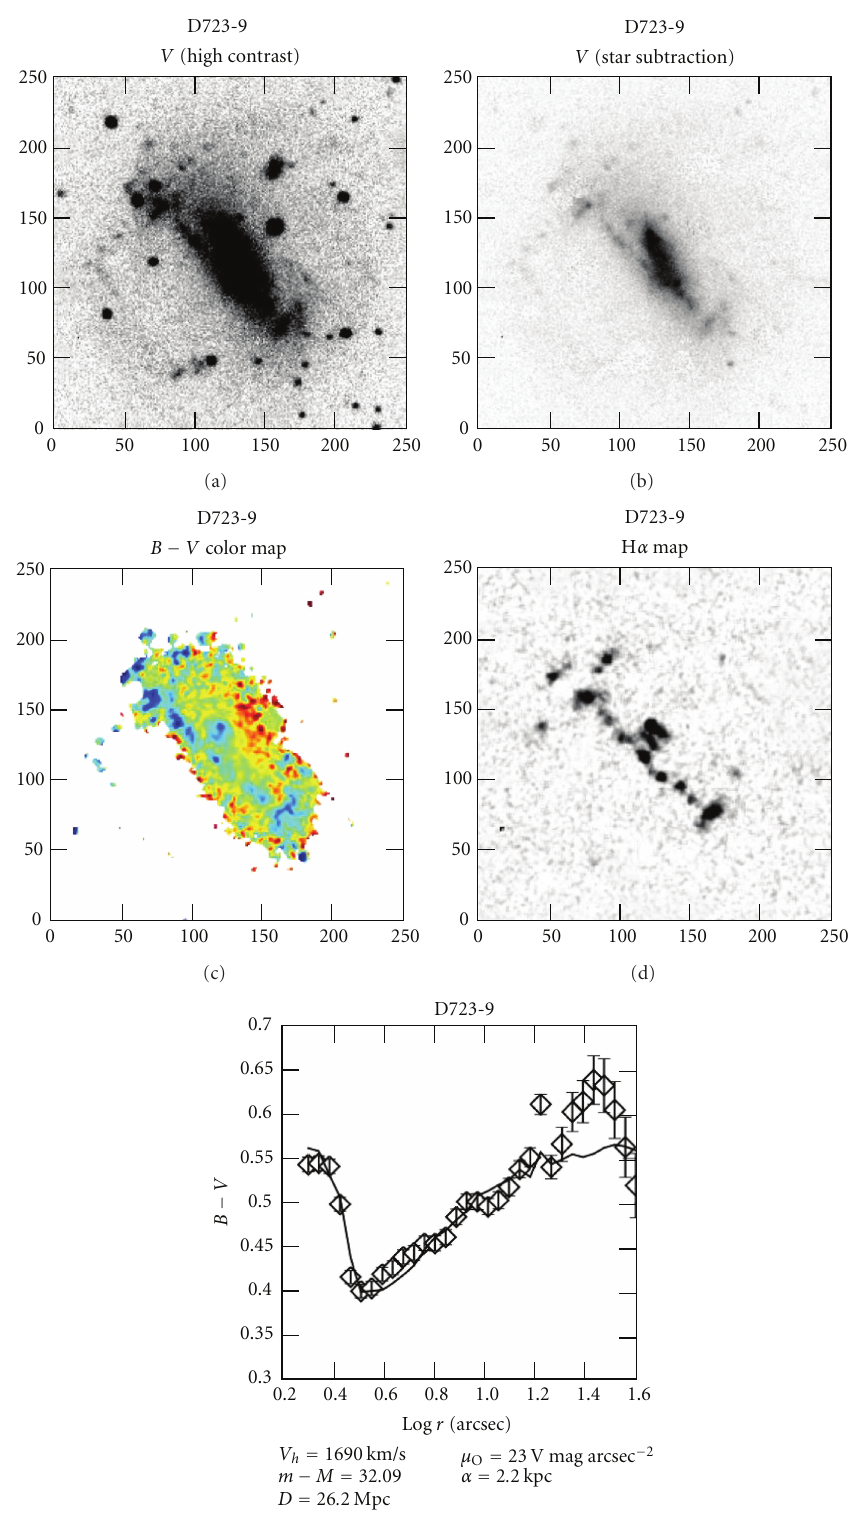
Figure 1: An example visual summary chart for galaxy D723-9. The top left panel is a high-contrast V image (to emphasize LSB features), axes are in pixel units, north at top, east to left. The top right panel is a low-contrast V image with foreground stars removed. The middle left panel is the B − V color map (blue is B − V = 0, red is B − V = 1). The middle right panel is the H α emission. The lower left panel is the B − V color profile (open symbols are di ff erential color, solid line is integrated color). Redshift, distance, central surface brightness, and scalelength ( α ) are also listed. All the galaxy charts can be found at http://abyss.uoregon.edu/ ∼